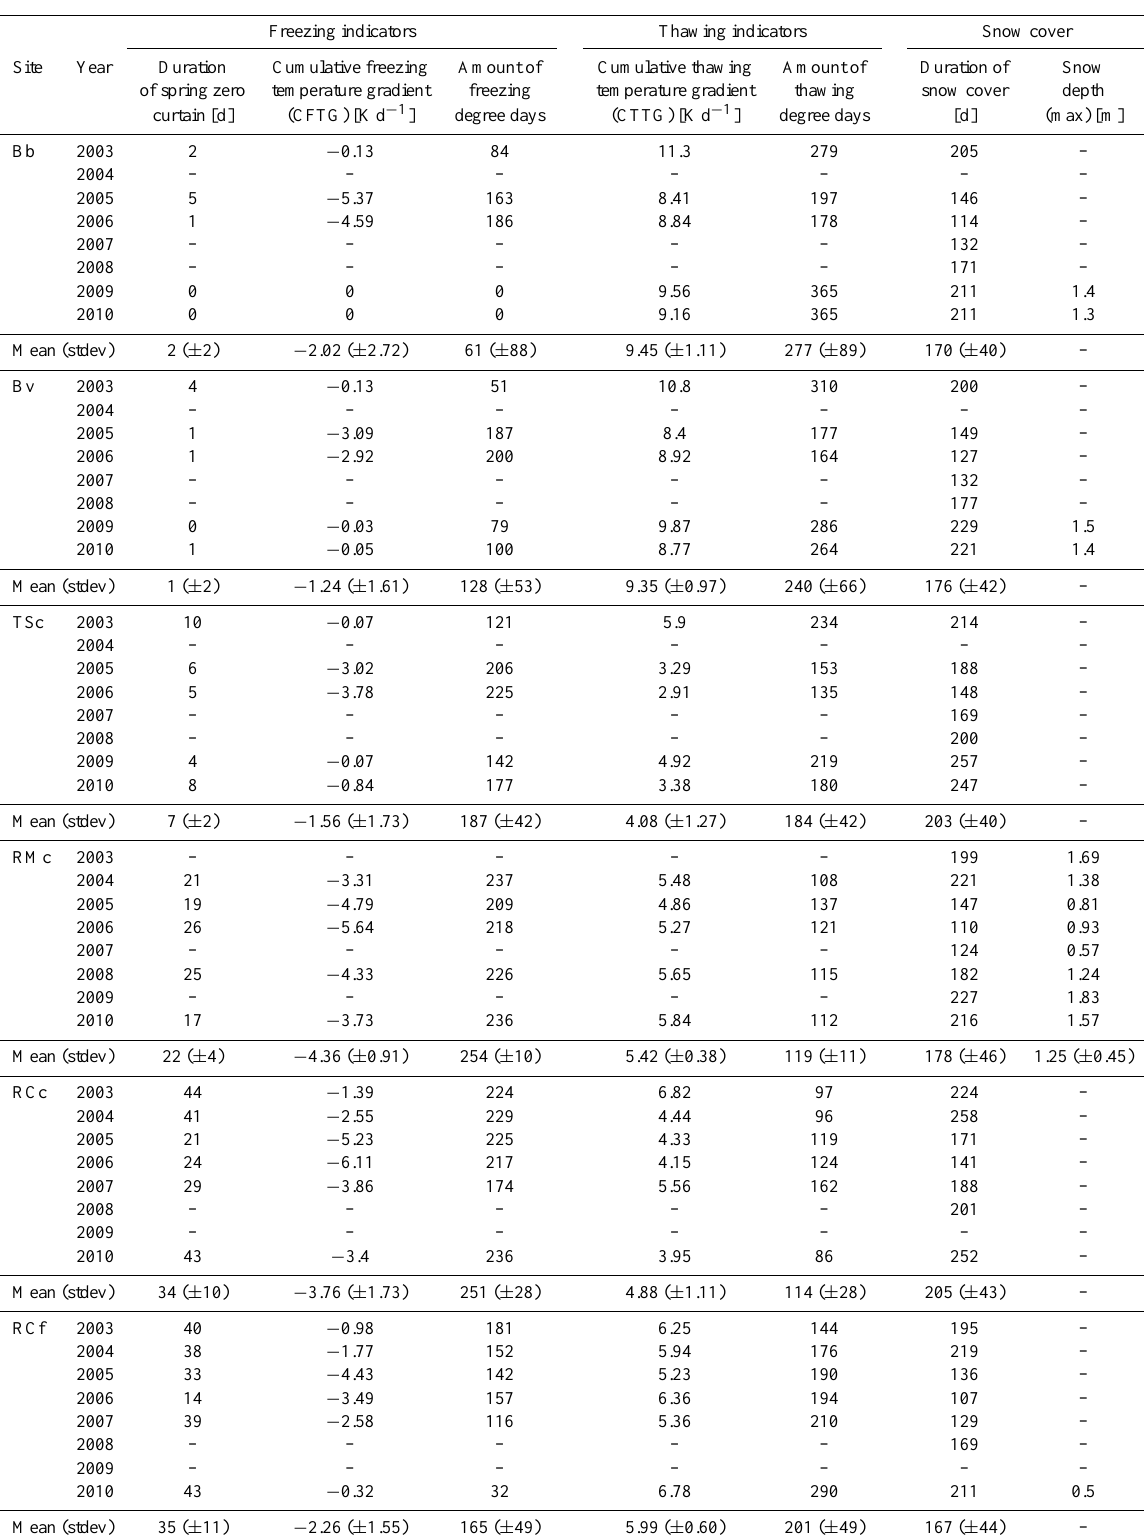
Table 2. Comparison of the snow cover (duration and height) and freezing and thawing indicators for the last eight years and for different sites for 1.5m depth. Freezing indicators are the cumulative freezing temperature gradient (CFTG), the annual amount of freezing degree days and the duration of the spring zero curtain. Thawing indicators are expressed by the cumulative thawing temperature gradient (CTTG) and the annual amount of thawing degree days. Values are calculated for hydrological years (i.e. 2003 starts on 1 October